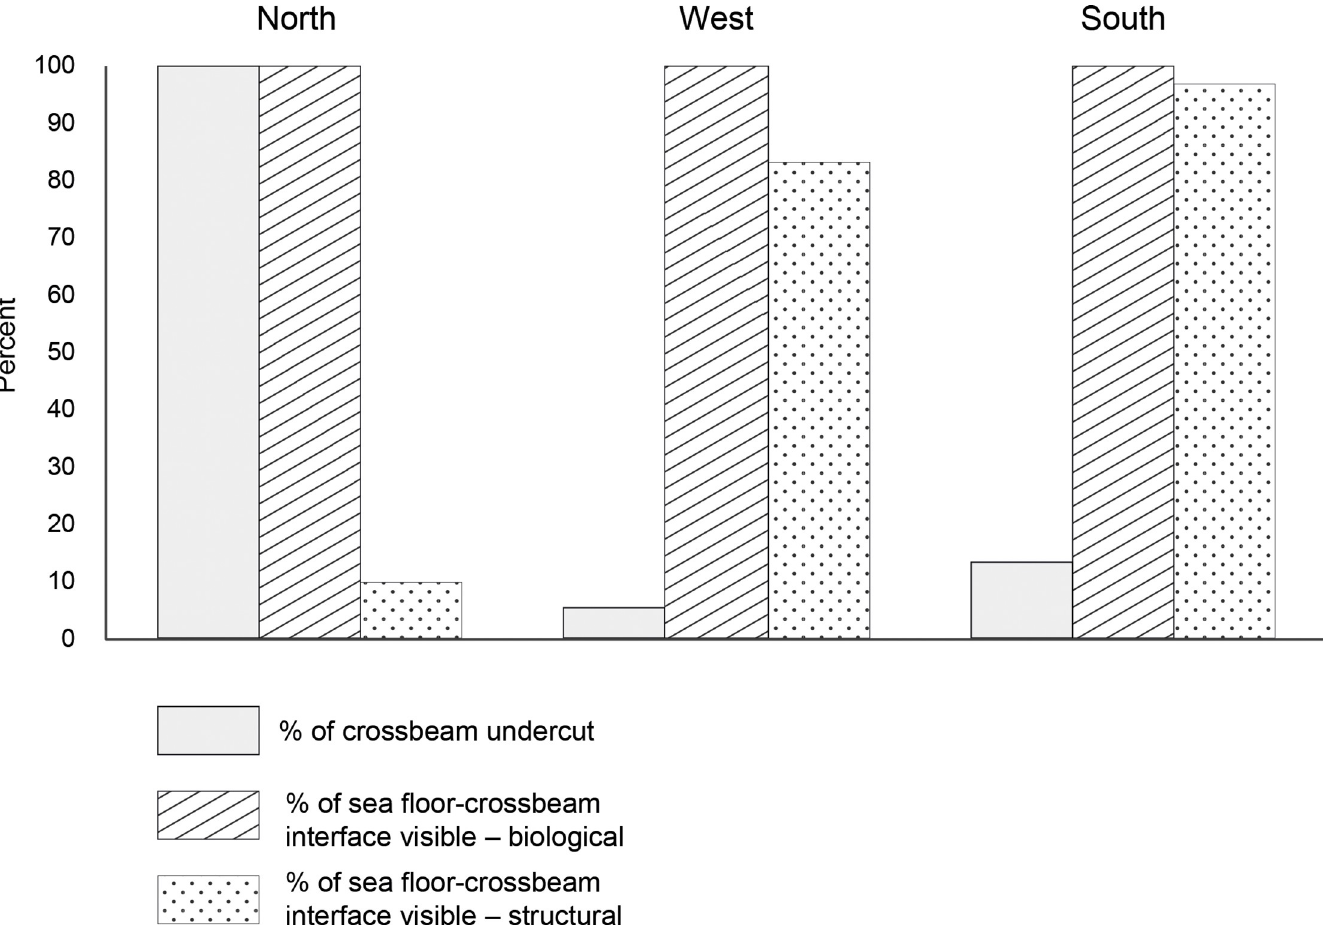
Fig 6. The percentage of the lengths of the north, west, and south crossbeams that were undercut, and the percentage of the seafloor-crossbeam interface that was visible at each crossbeam using the biological and structural survey method. The entire length (100%) of the seafloor-crossbeam interface along each crossbeam was visible in the biological survey.